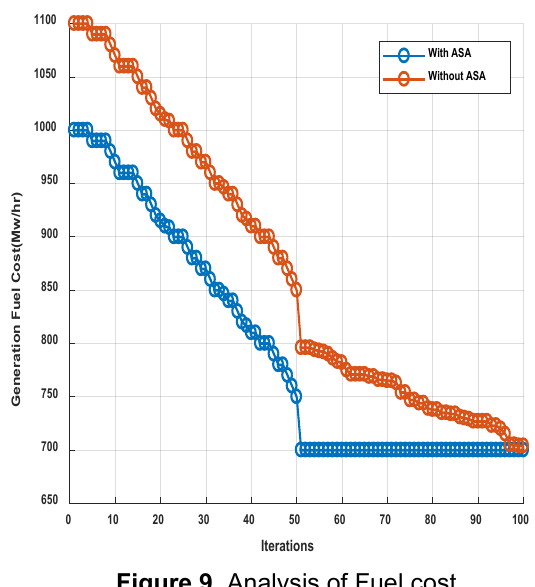
Figure 9. Analysis of Fuel cost